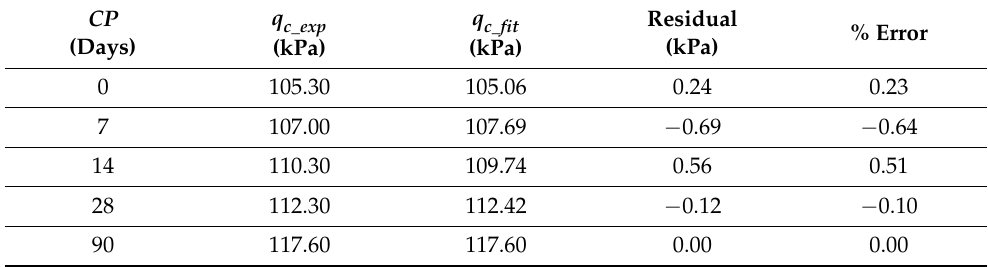
Table 6. The nonlinear equations for the UCS ( q c _ fit ) of untreated clay measured after 0, 7, 14, 28, and 90 days of curing.